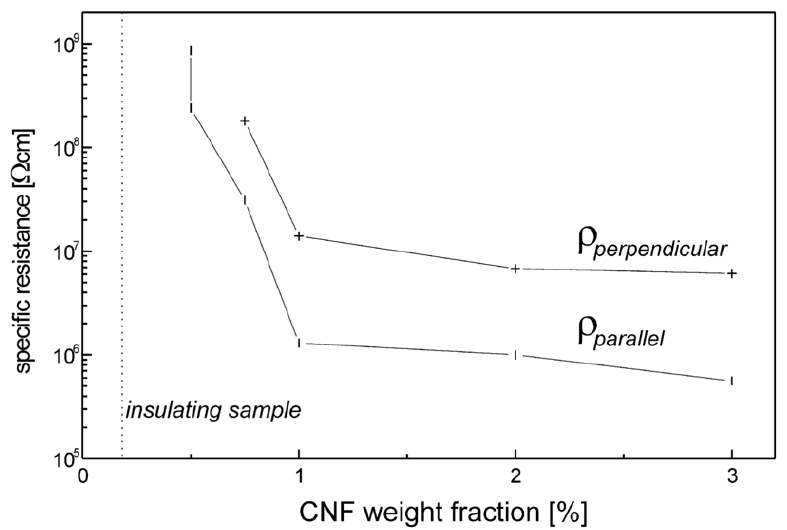
Figure 41. Resistivity as a function of CNF weight fraction in cured composites for directions parallel and perpendicular to the electric field. Reprinted from [113], Copyright 2003, with permission from Elsevier.